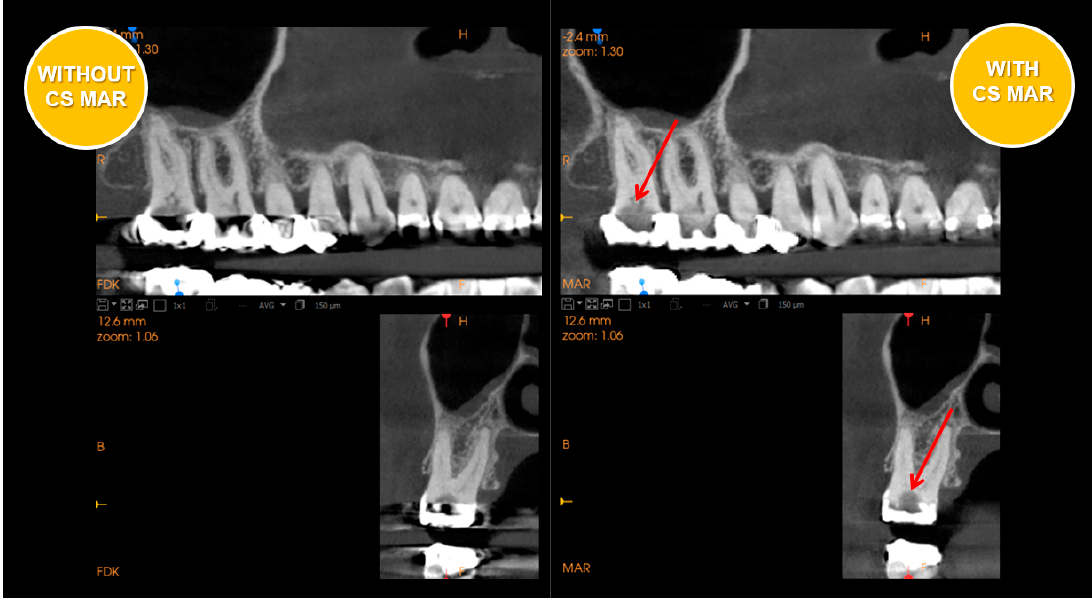
Figure 2. Sagital views of CBCT with and without Metal artifact reduction (MAR) - (Carestream CS9600 MAR).